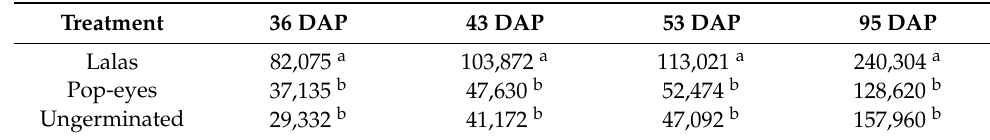
Table 3. Mean number of tillers per hectare (Tillers ha − 1 ) in response to bud germination levels in field experiment a .